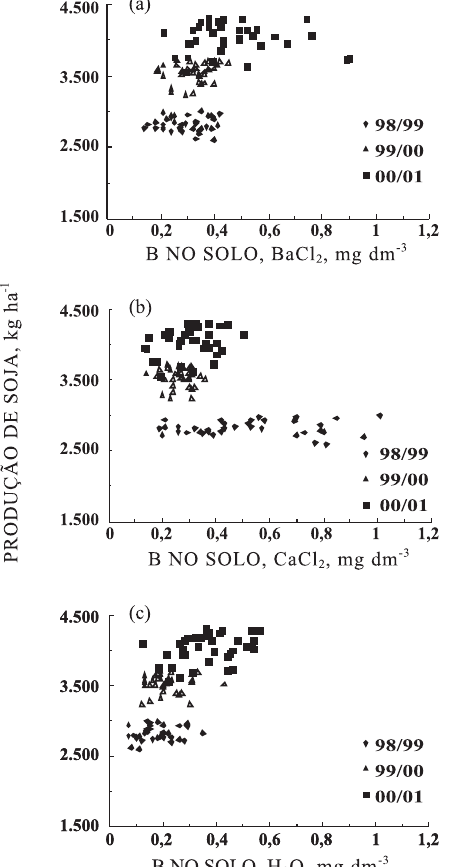
Figura 6. Produção de soja em função dos teores de B no solo, nos três anos de realização do experimento, para os três extratores. (a) BaCl